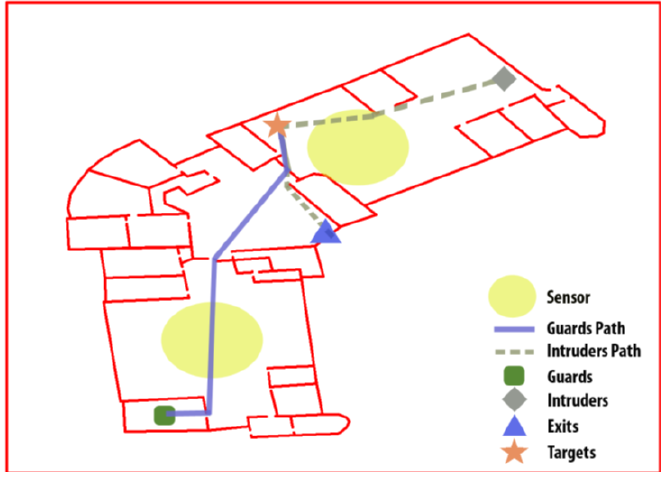
Figure 1. An scene with obstacle-walls and several key elements: one guard and his path to the target, one intruder and his path to the target and the exit, two sensors, one target and one